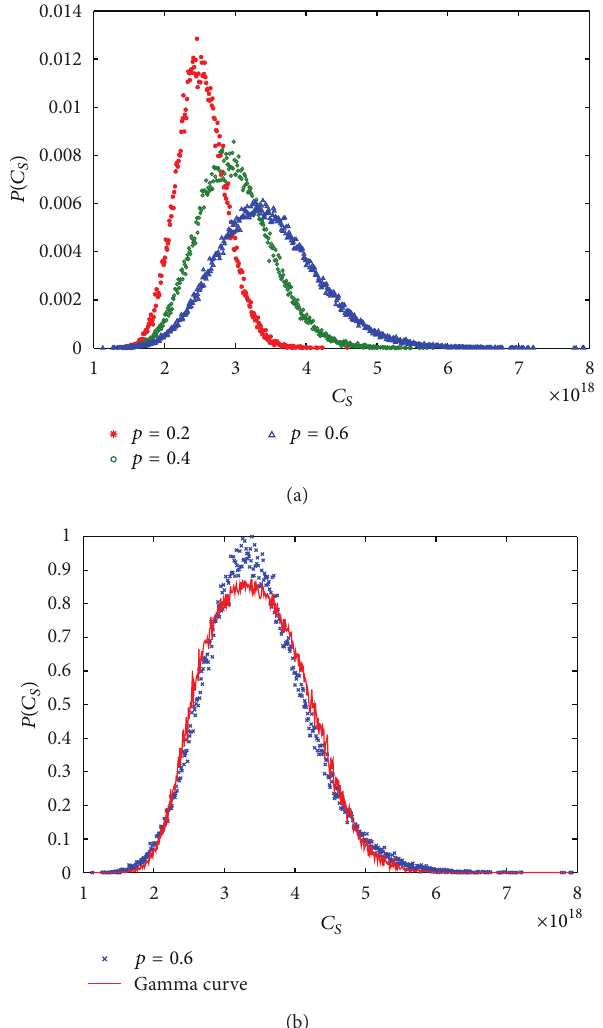
Figure 9: (a) Probability distributions of subgraph centrality 𝑃(𝐶 𝑆 ) in the WS network model with three rewiring probabilities 𝑝 = 0.2 (red circles), 𝑝 = 0.4 (green squares), and 𝑝 = 0.6 (blue diamonds). (b) Probability distributions of subgraph centrality 𝑃(𝐶 𝑆 ) with 𝑝 = 0.6 and the fitting curve of gamma distribution with 𝛼 = 1.62 and 𝛽 = 0.33 . All networks have 𝑁 = 2500 .